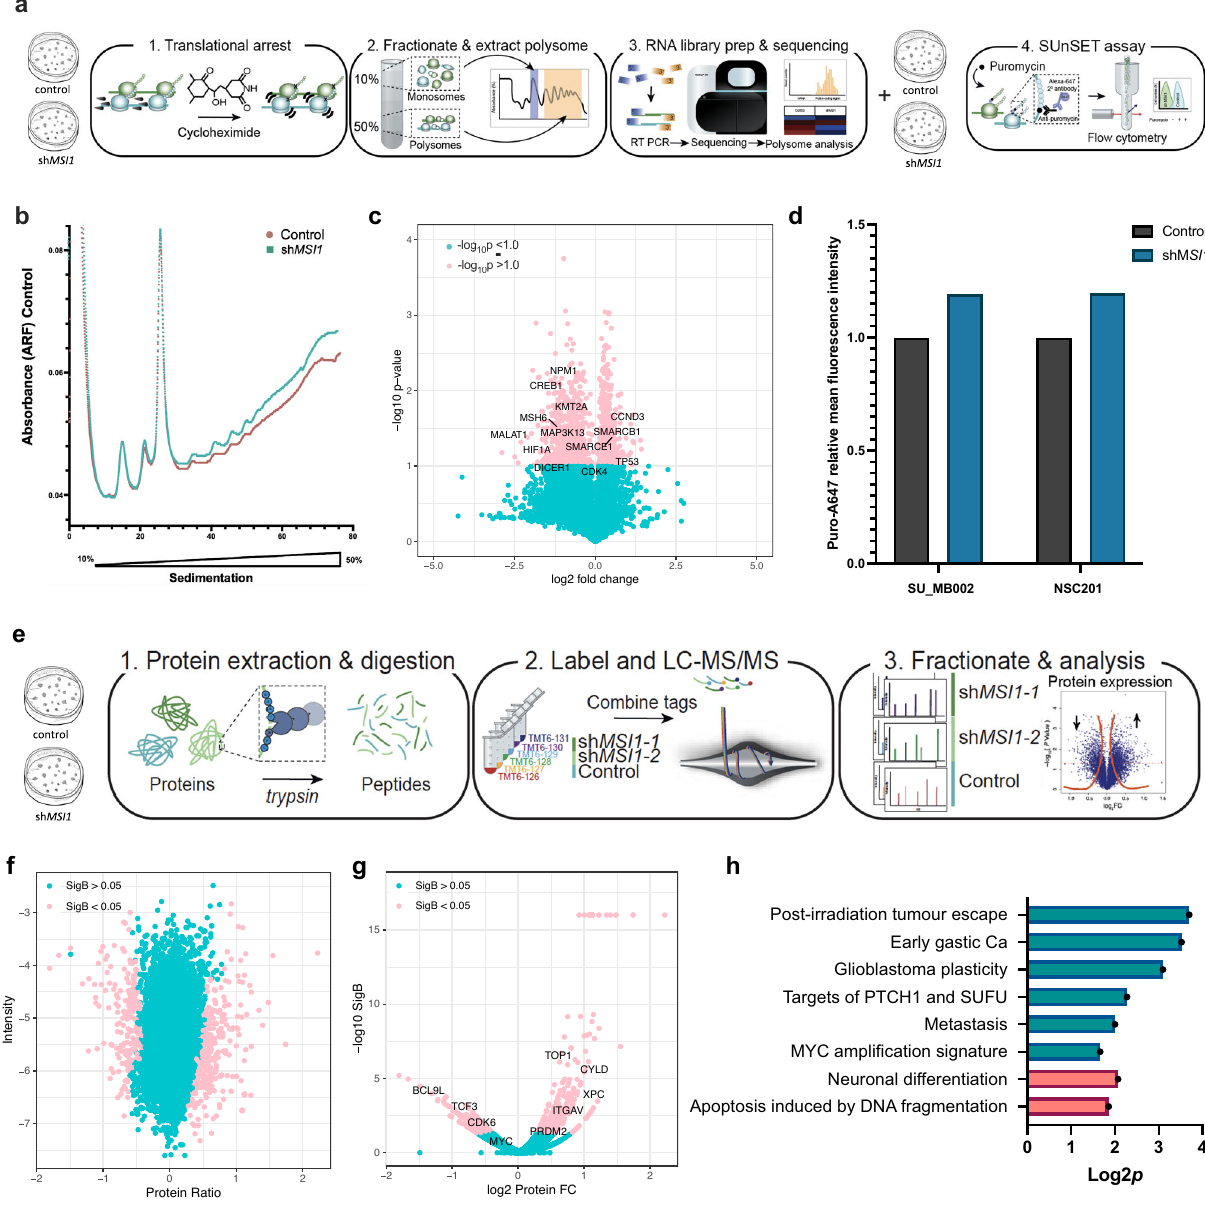
Fig. 3 | Polysome pro fi ling and sequencing and SuNSET assay suggests MSI1 is aberrantly impeding the association of transcripts with ribosomes with sub- sequent whole shot gun proteomic analysis identifying downregulation of proteins associated with cancer aggressiveness. a Schematic of experimental plan to investigate the ribosome associated fraction of mRNA and validation of global translational process with SuNSET assay, b Polysome pro fi le of control vs sh MSI1 SU_MB002 illustrating an increased mRNA polysome associated fraction in sh MSI1 inhibited samples, c Polysome-seq identi fi es key cancer associated genes that are down regulated in the polysome fractions after sh MSI1 inhibition in SU_MB002, d SuNSET assay after normalization shows a trend towards